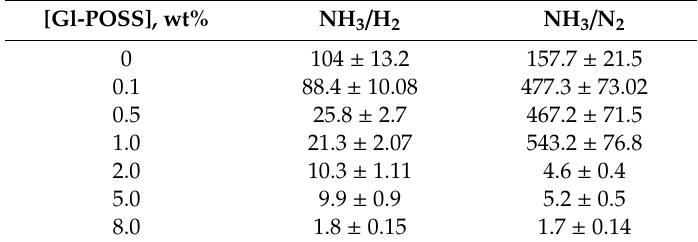
Table 3. The ideal selectivity of the ammonia / gas system of POI-Gl-POSS membranes, measured at